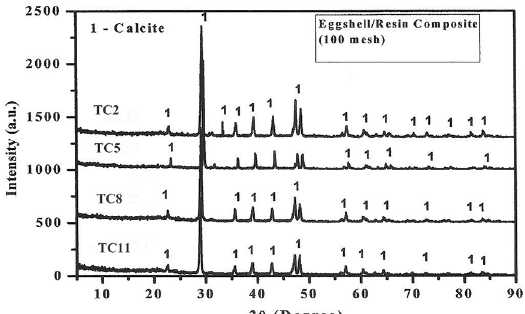
Figure 3. X-ray diffraction pattern of the artificial rocks produced with chicken eggshell waste (< 100